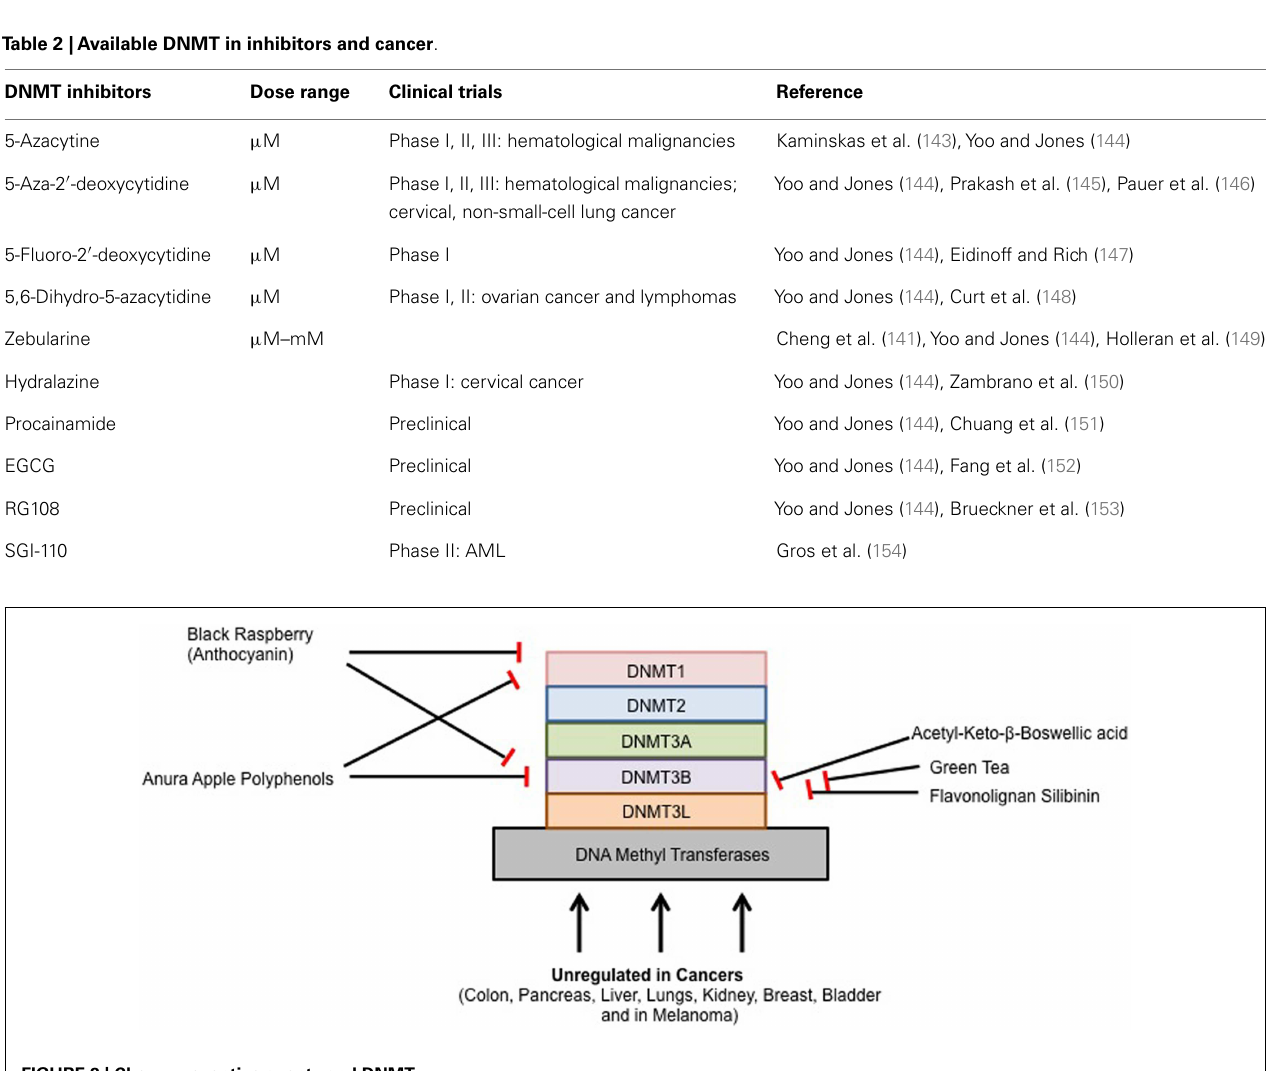
FIGURE 2 | Chemopreventive agents and DNMTs